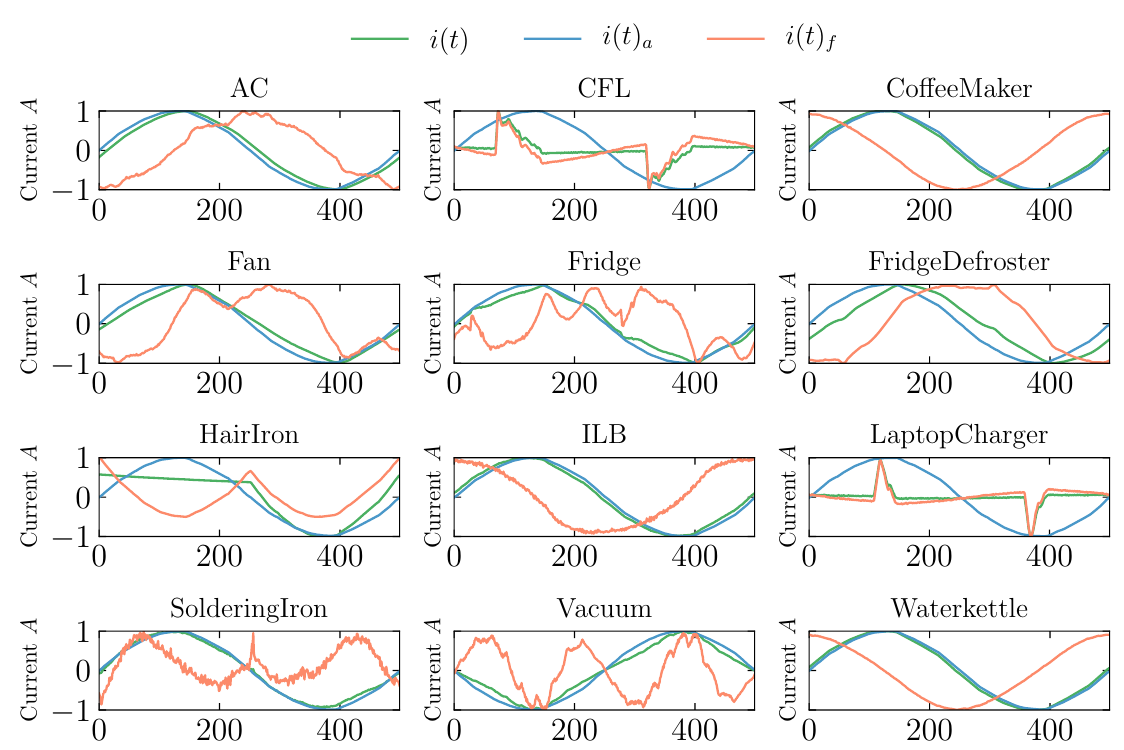
Figure 4. Normalized source current i ( t ) and their respective active i ( t ) a and reactive components i ( t ) f after applying Fryze power theory. The current is normalized for visualization purposes.